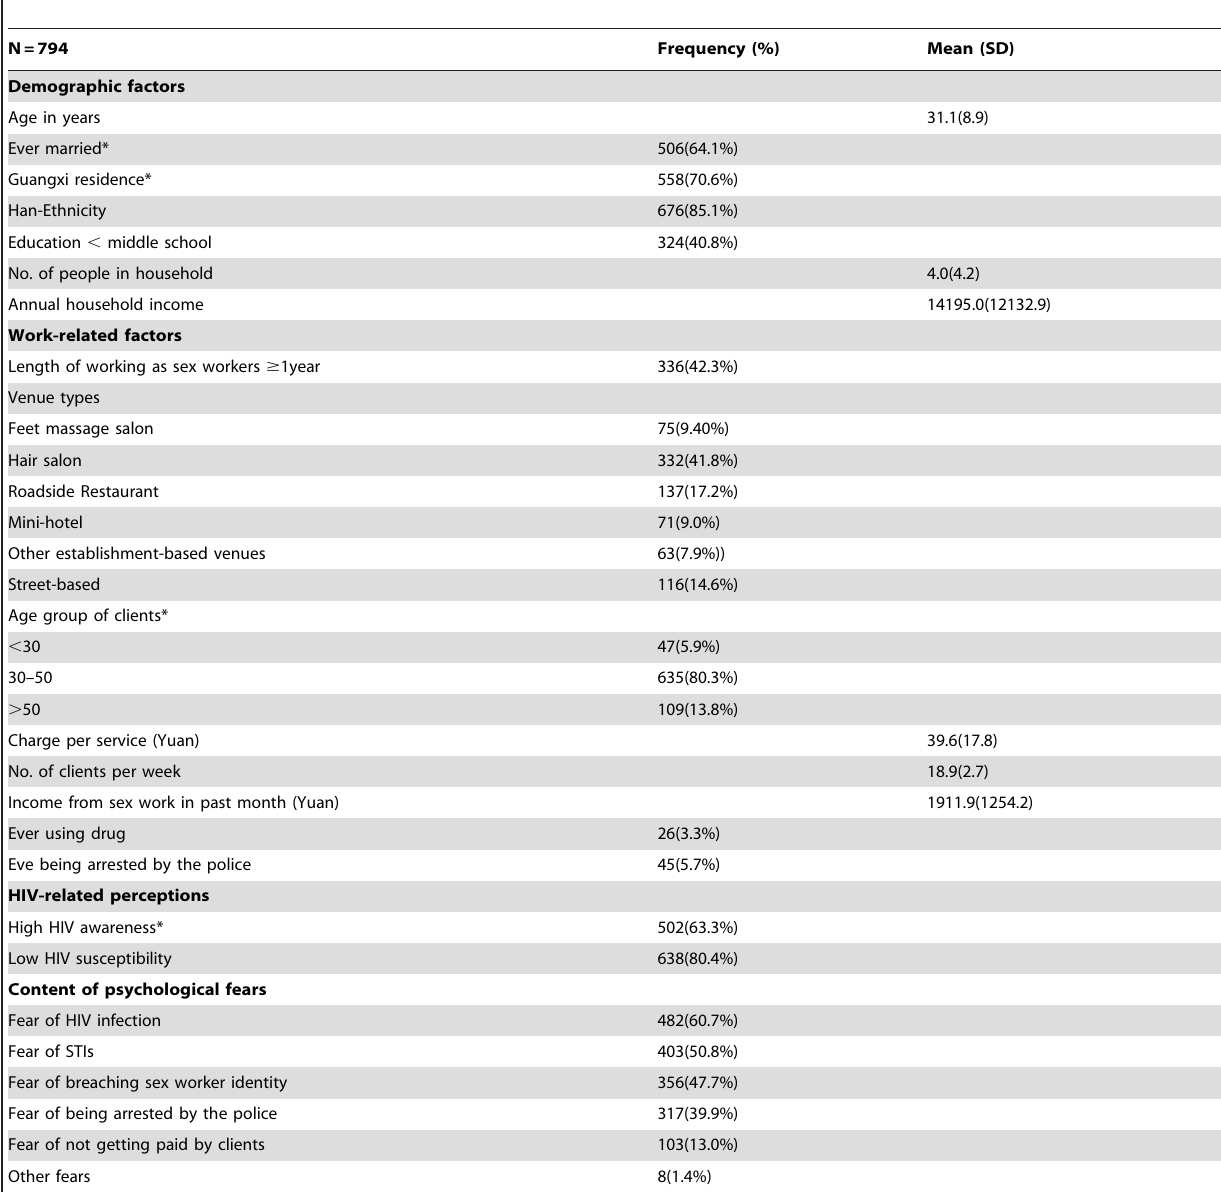
Table 1. Summary of background characteristics among low-paid FSWs in